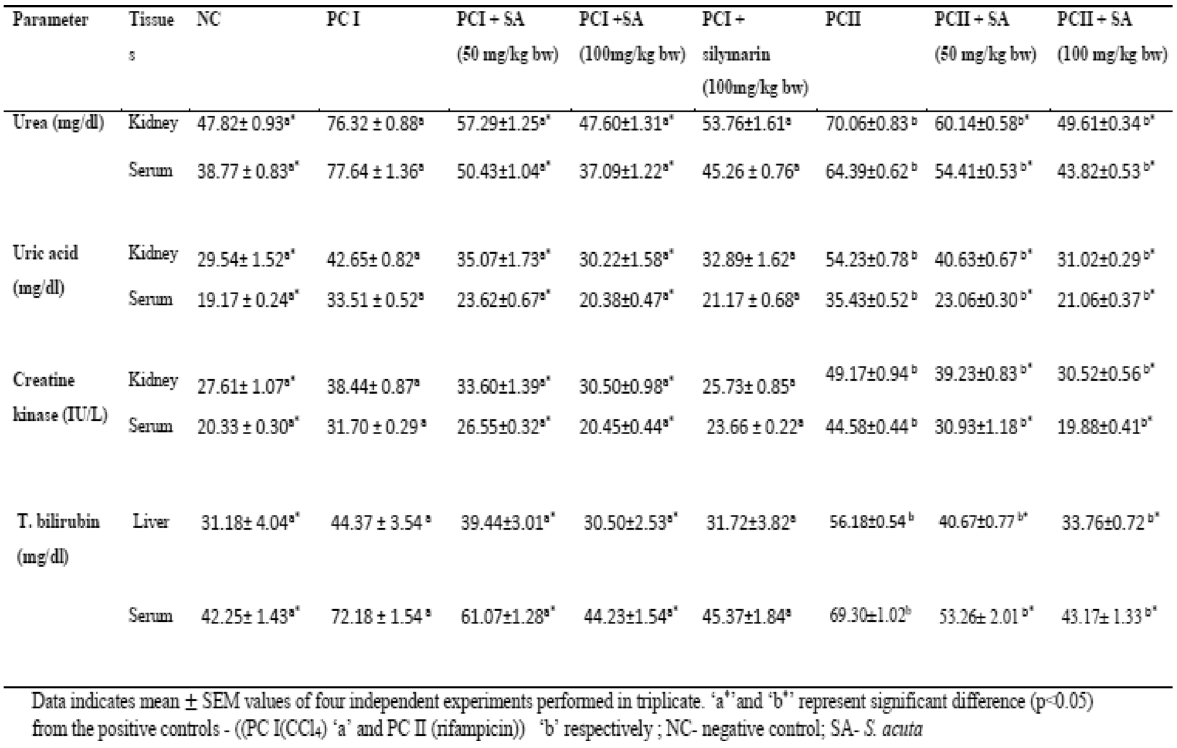
Table 5 Effect of S. acuta extract on selected biomarkers of liver and kidney toxicity in rats exposed to CCI 4 and rifampicin